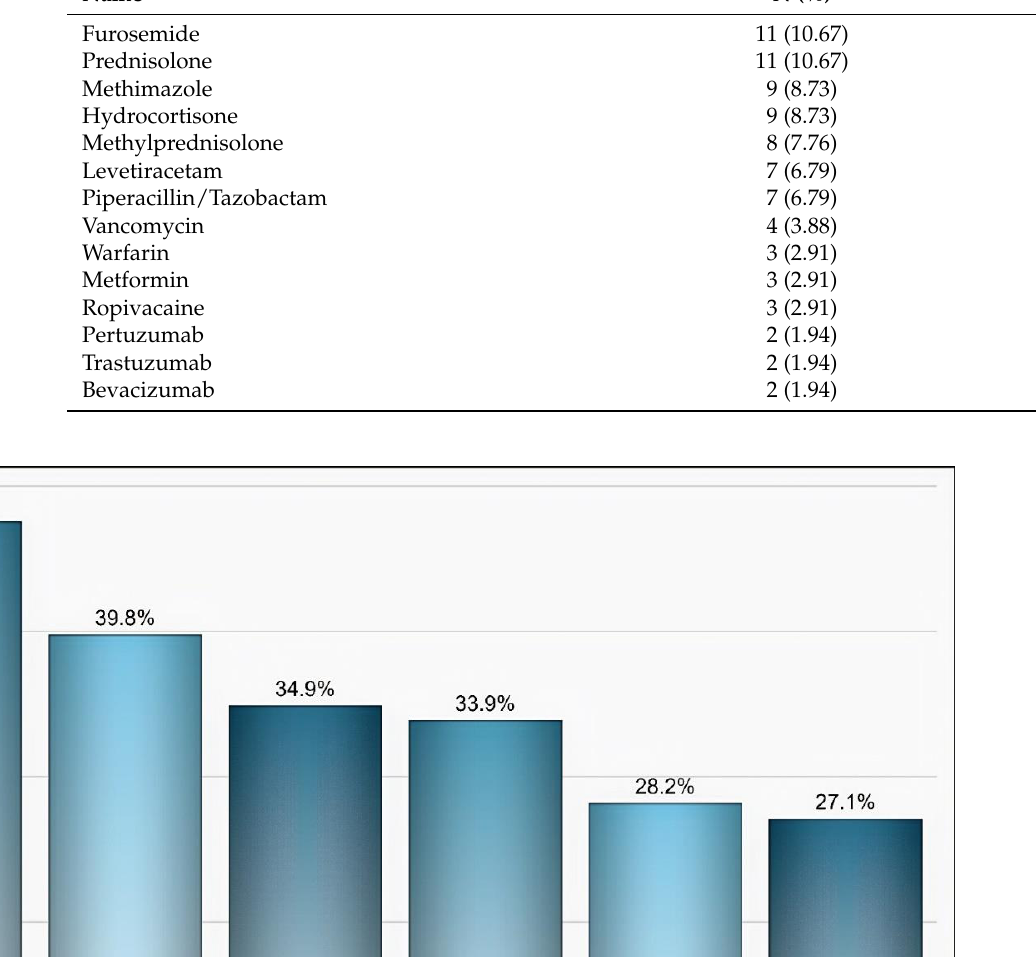
Figure 3. The impact of COVID-19 on prices of drugs in short supply based on participants ’ responses.